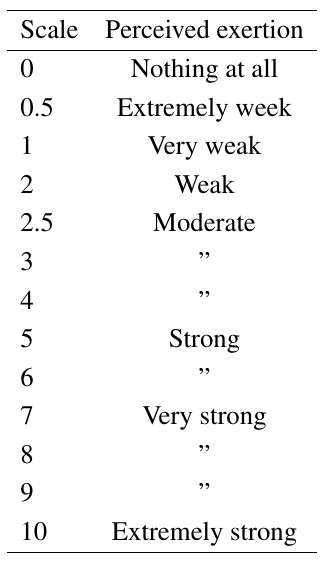
Table 2. 10 point scale